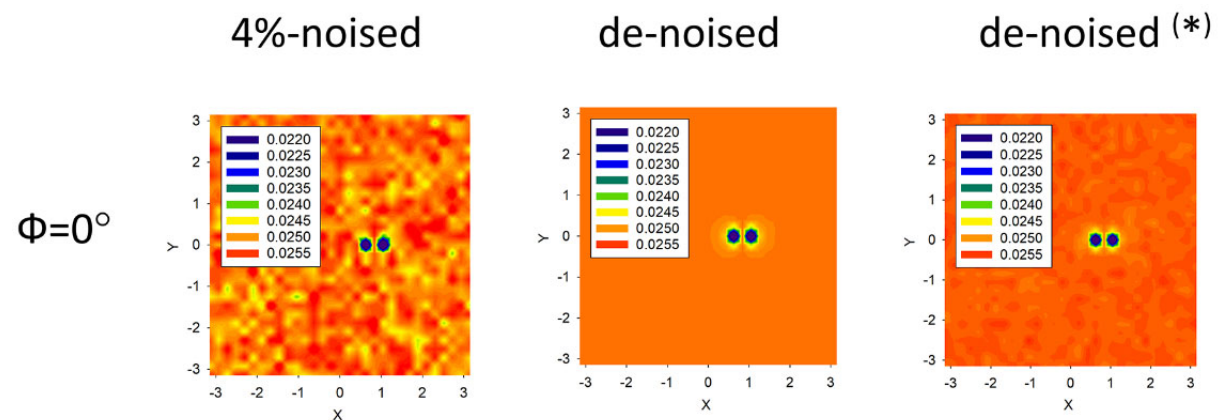
Figure 4. The 2D IPs frames: the 4%-noise level (left) and the de-noised ones. The number U of the frames under the average (de-noised) and geometric (de-noised ( * ) ) Means processing is equal to 100. The sample rotation angle Φ = 0°. Table 1. The Coulomb-type point defect in crystal Si(111). The sample rotation angles Φ i are in the range ( − 20°, 20°). The true vector 𝓟 (cid:4666)(cid:3047)(cid:3045)(cid:3048)(cid:3032)(cid:4667) ={1.50, 0.50, 1.80} is chosen for the Coulomb-type point defect. The start iteration vector 𝓟 (start) ={1.70, 0.55, 1.40}. Total grid crystal sizes along the dimen- sionless coordinates ( X , Y , Z ) are equal to 61×61×21. The case of the Poisson-noise with the levels of 2% and 4% are considered. Note bene: Data in the two lines marked with asterisk ( * ) relate to the XRDT recovery processing by means of using the geometric means of the single 2D Poisson-noise IPs data frames.